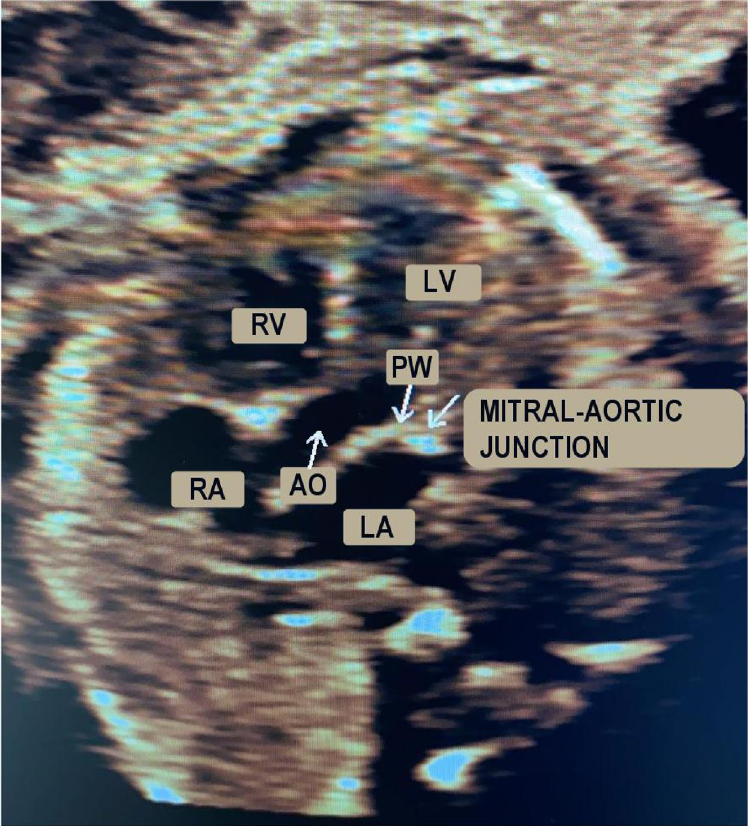
Fig 1. Apical five-chamber B-mode view of the fetal heart. In detail: right ventricle (RV), right atrium (RA), left ventricle (LV), left atrium (LA), aortic region (AO) and sample volume positioning